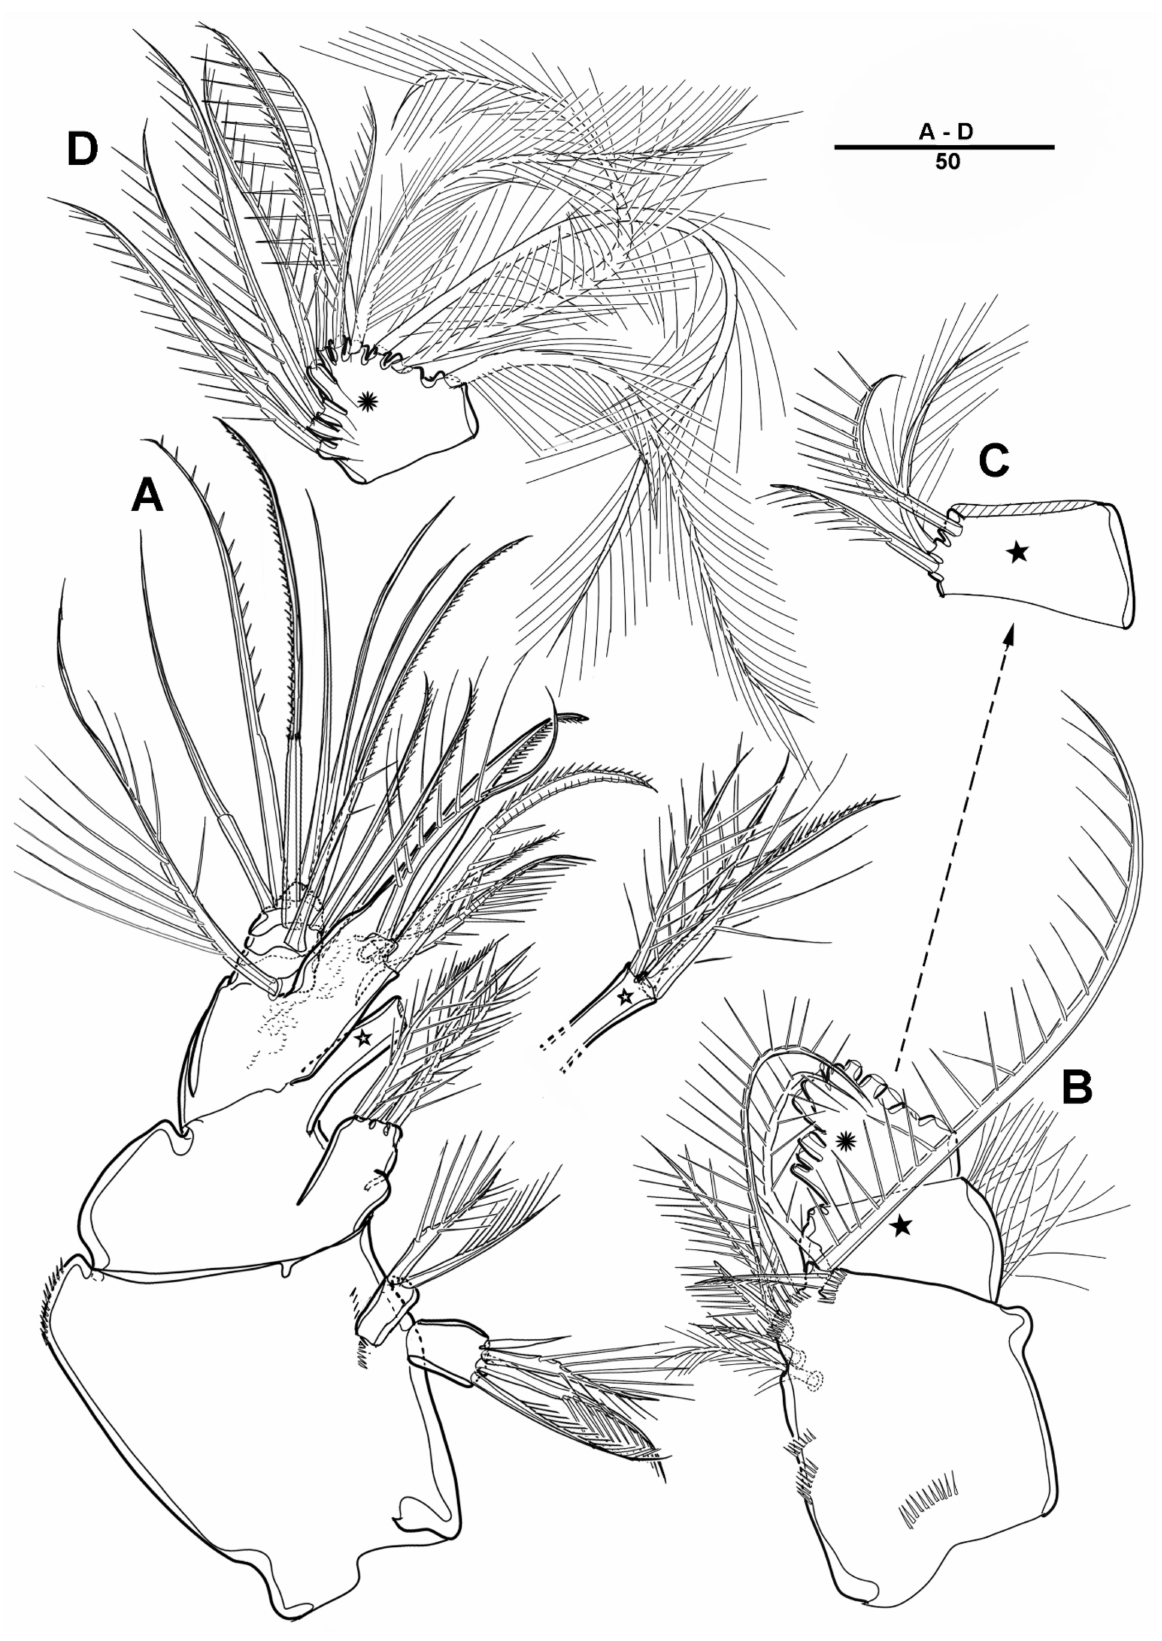
Figure 16. Scottolana wonchoeli sp. nov. holotype female: ( A ) maxilla (asterisk indicated distal coxal endite); ( B ) maxilliped; ( C ) maxillipedal basis; ( D ) maxillipedal endopod. Scale bars in µ